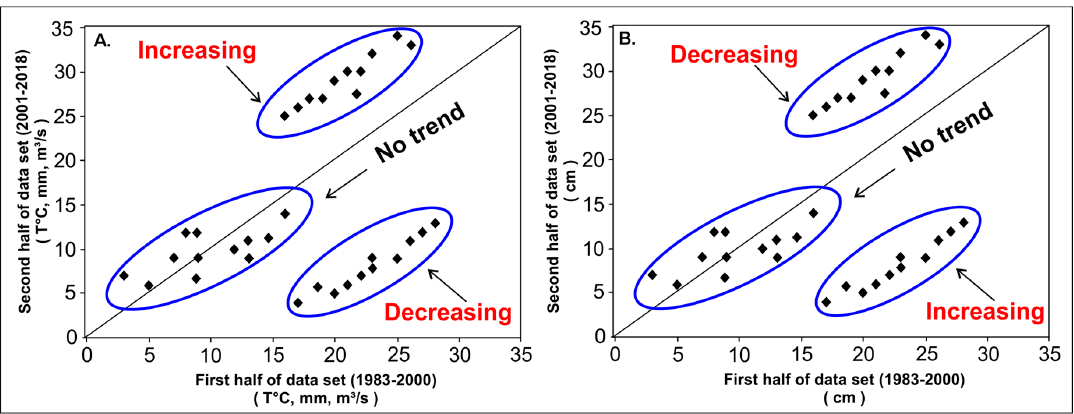
Figure 2. Graphical interpretation for climatic and hydrological parameters ( A ) and groundwater level ( B ) trends using innovative trend analysis (ITA).